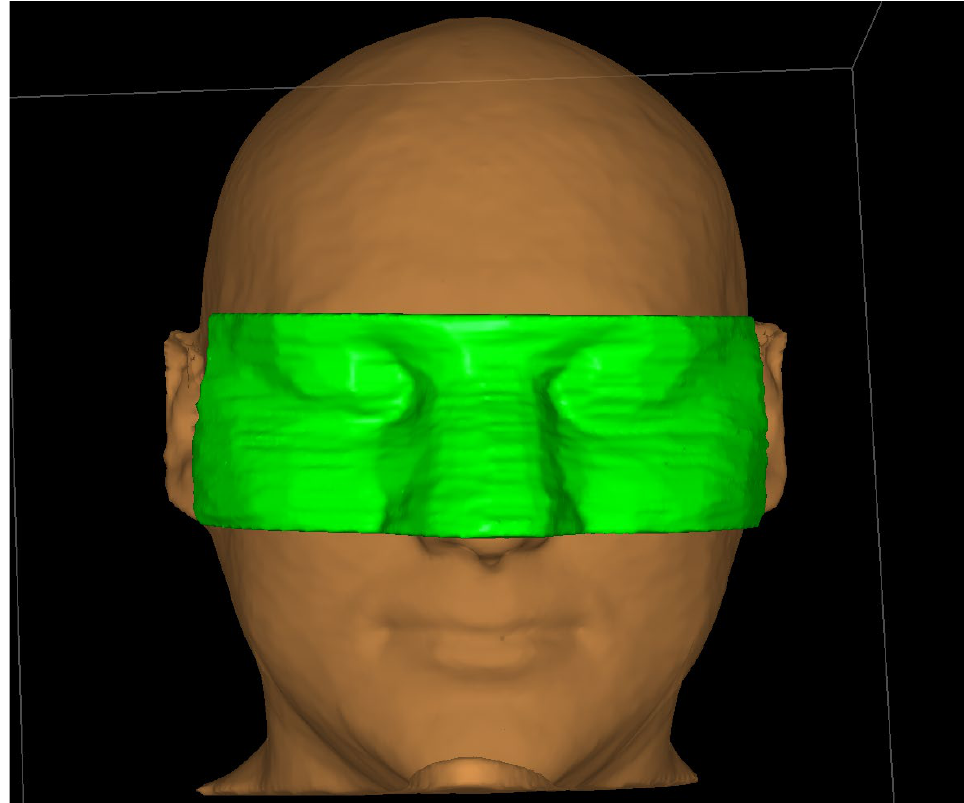
Figure 3. Personalized surface applicator for superficial brachytherapy (prepared as a bolus structure) which was used for purpose of this study.